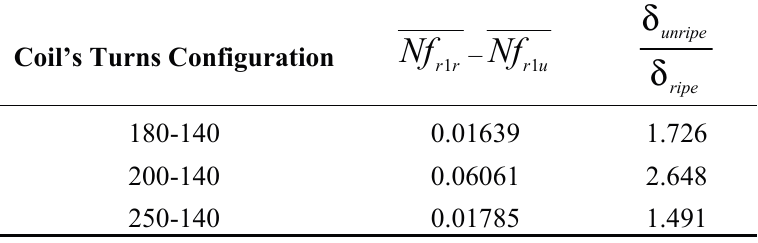
Figure 10. Ratio between δ unripe and δ ripe for each coil turn